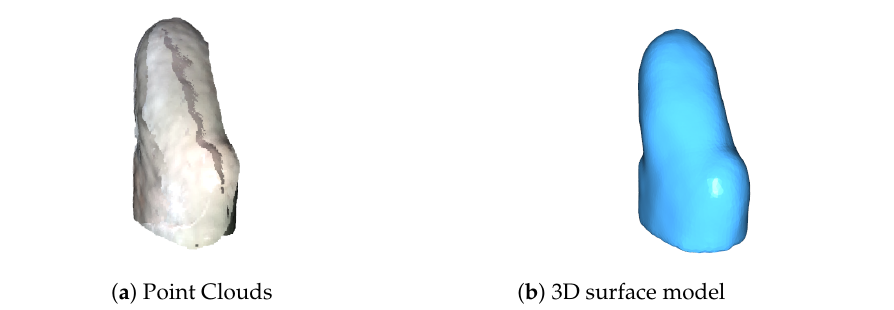
Figure 12. Comparison of ( a ) the initial global 5 images alignment and ( b ) the output model after applying a refined ICP registration and Poisson surface reconstruction. This shows the input and the output of the reconstruction algorithms.